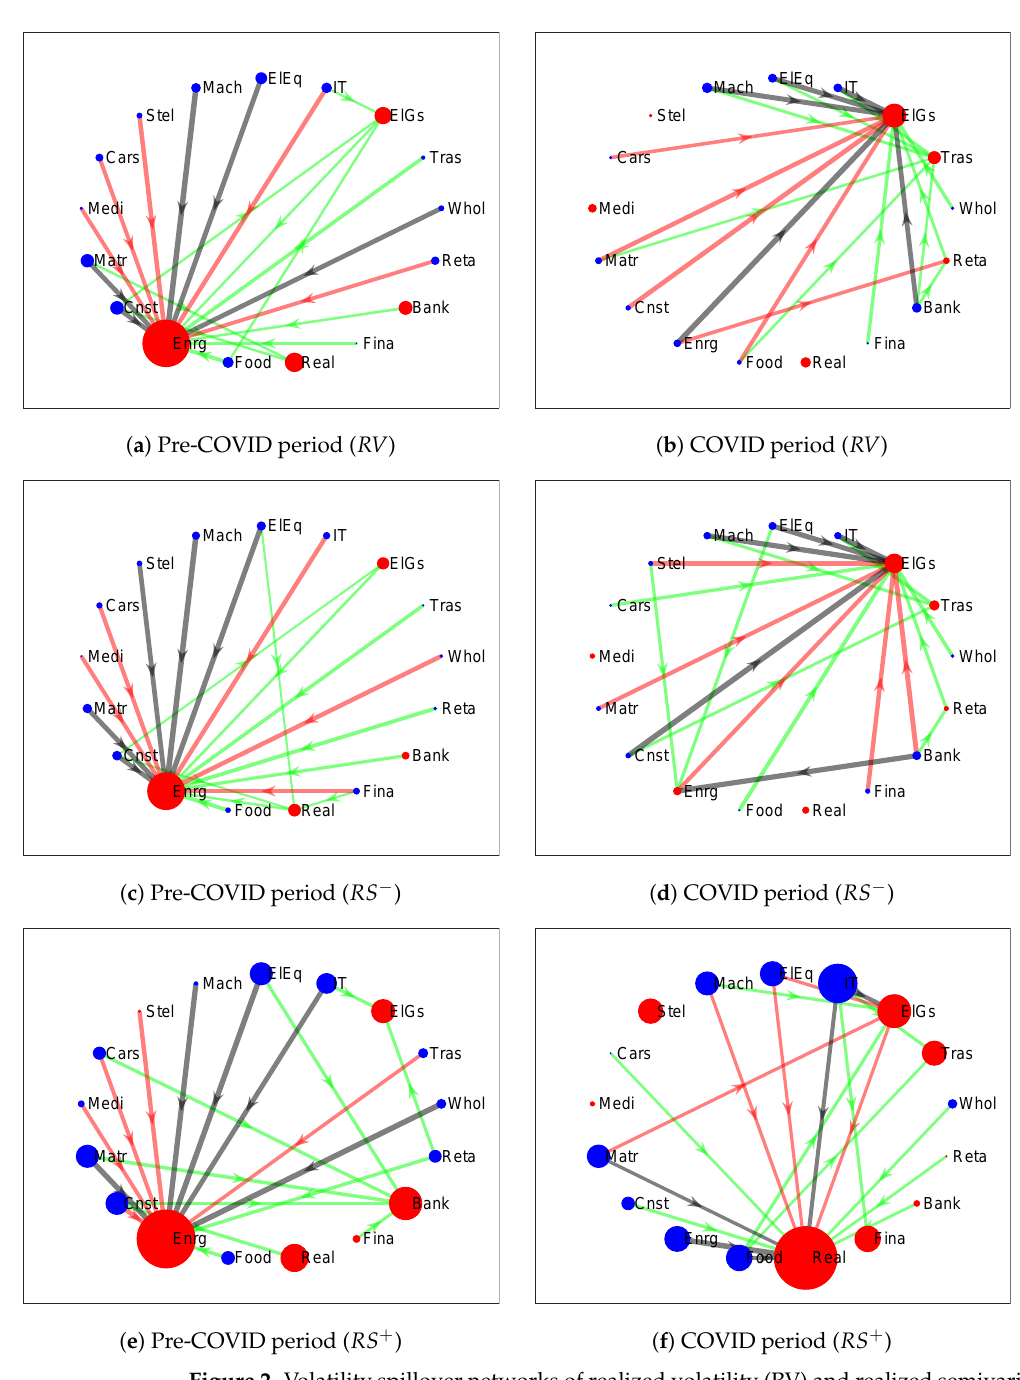
Figure 2. Volatility spillover networks of realized volatility (RV) and realized semivariance (RS) using NET and net pairwise spillover